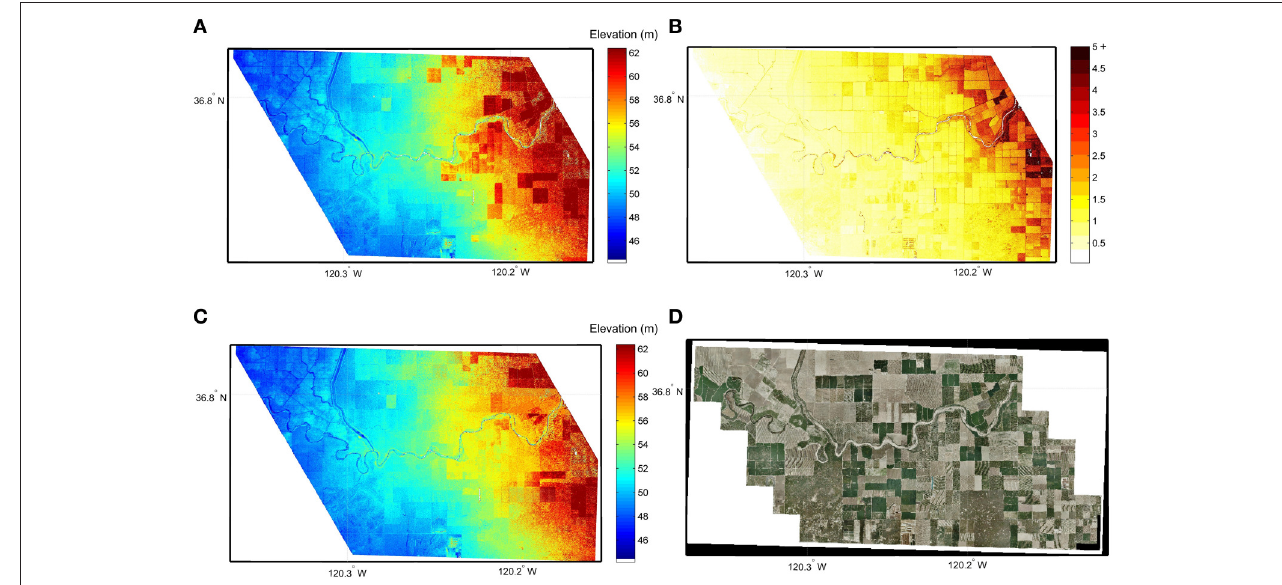
FIGURE 2 | (A) InSAR DEM, linearly calibrated (3 Aerial photography of the same area.